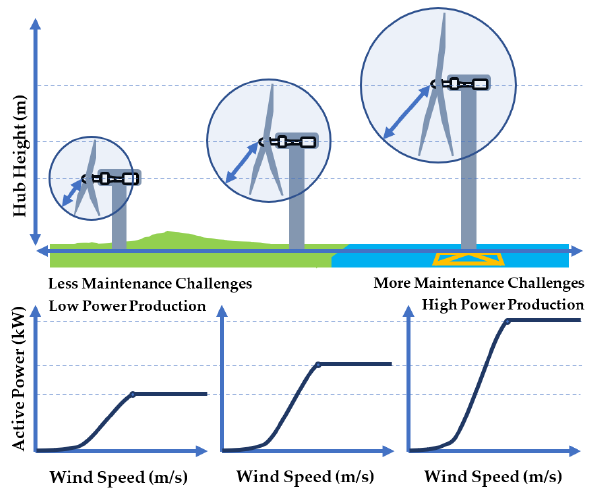
Figure 2. Wind turbine types and the corresponding power curves.